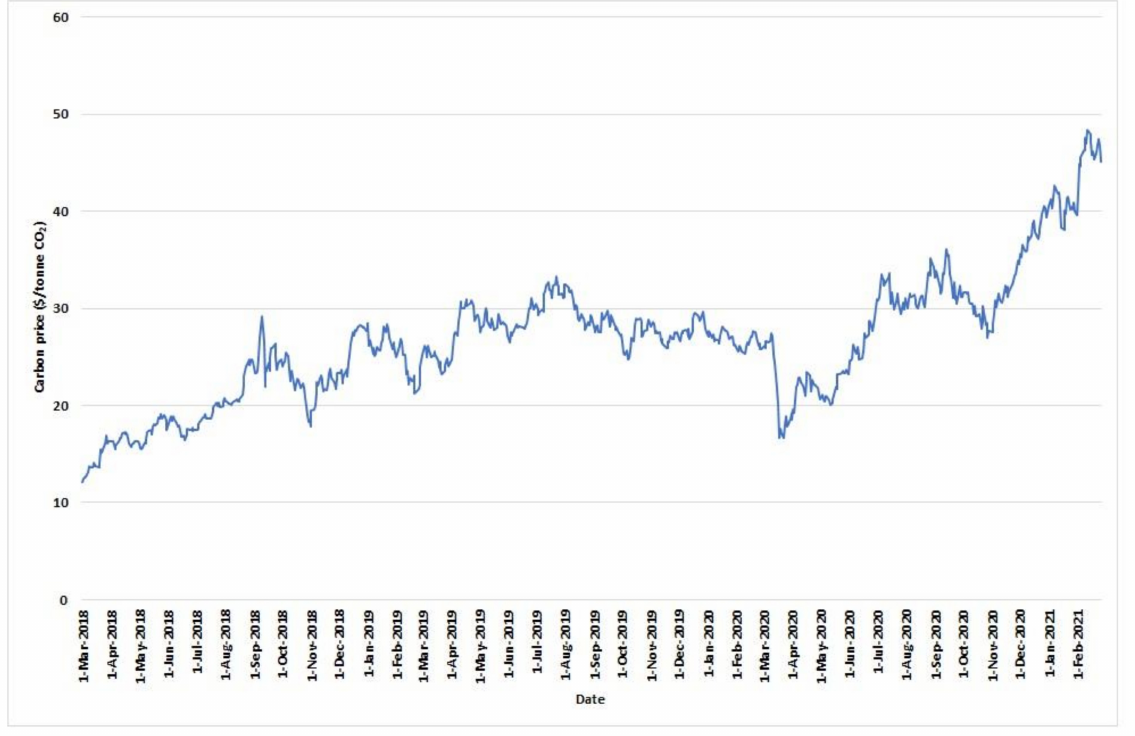
Figure 7. Carbon prices for three years (from 1 March 2018 to 26 February